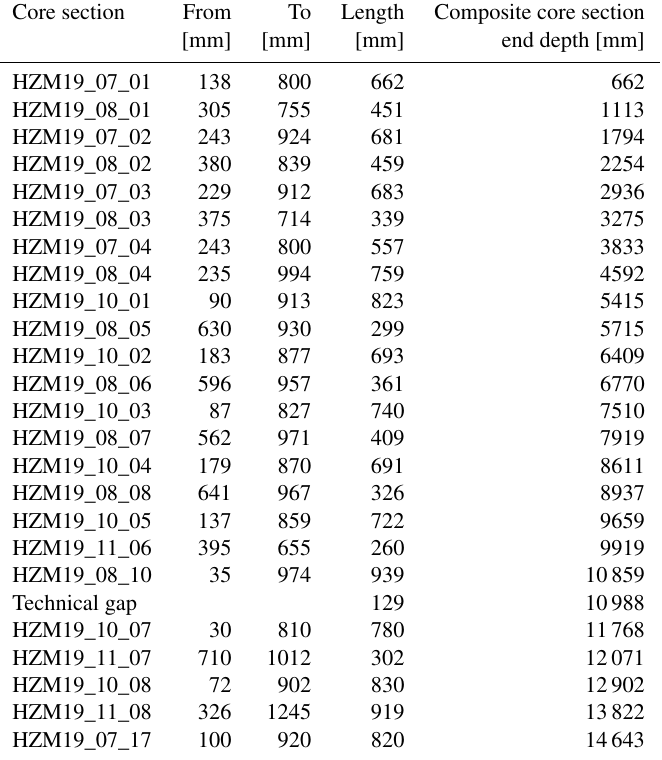
Table A4. Core section depths of the composite profile HZM19 with resulting composite end depths for each core. Core